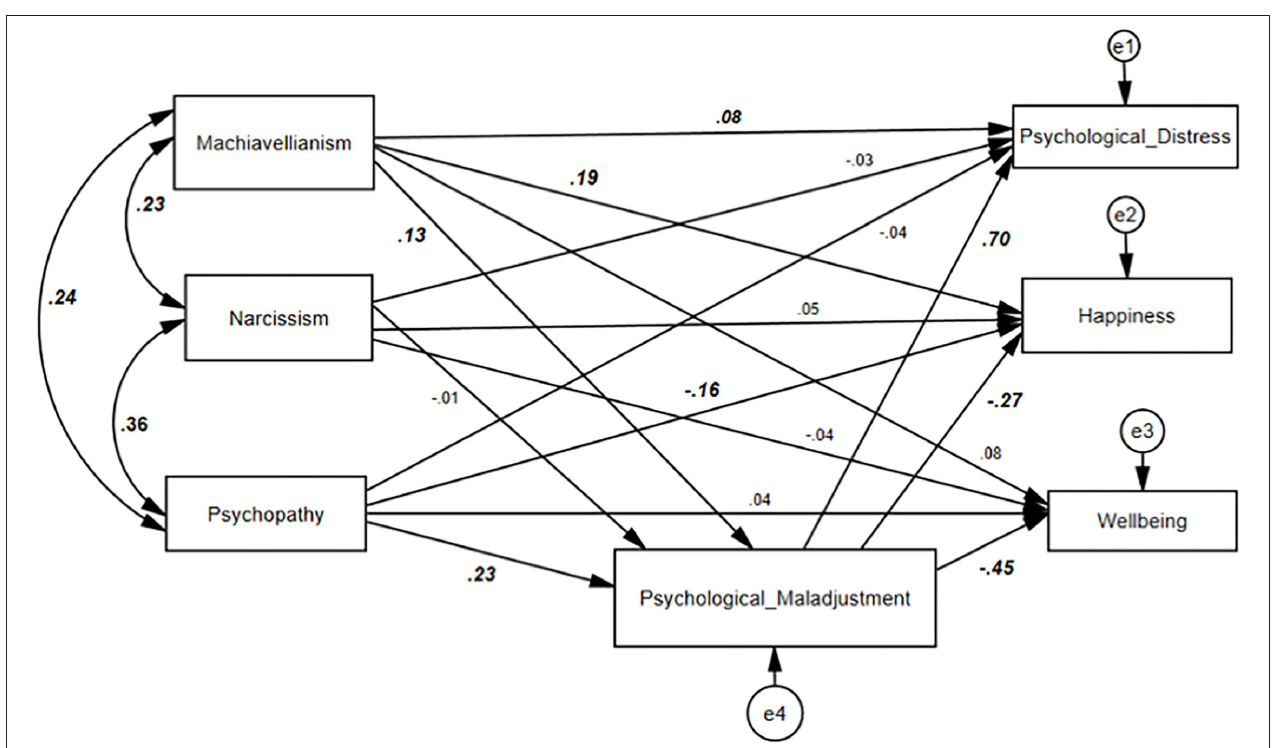
FIGURE 2 | Structure equation model predicting emerging adults’ psychological distress and happiness. Significant paths coefficients are presented in